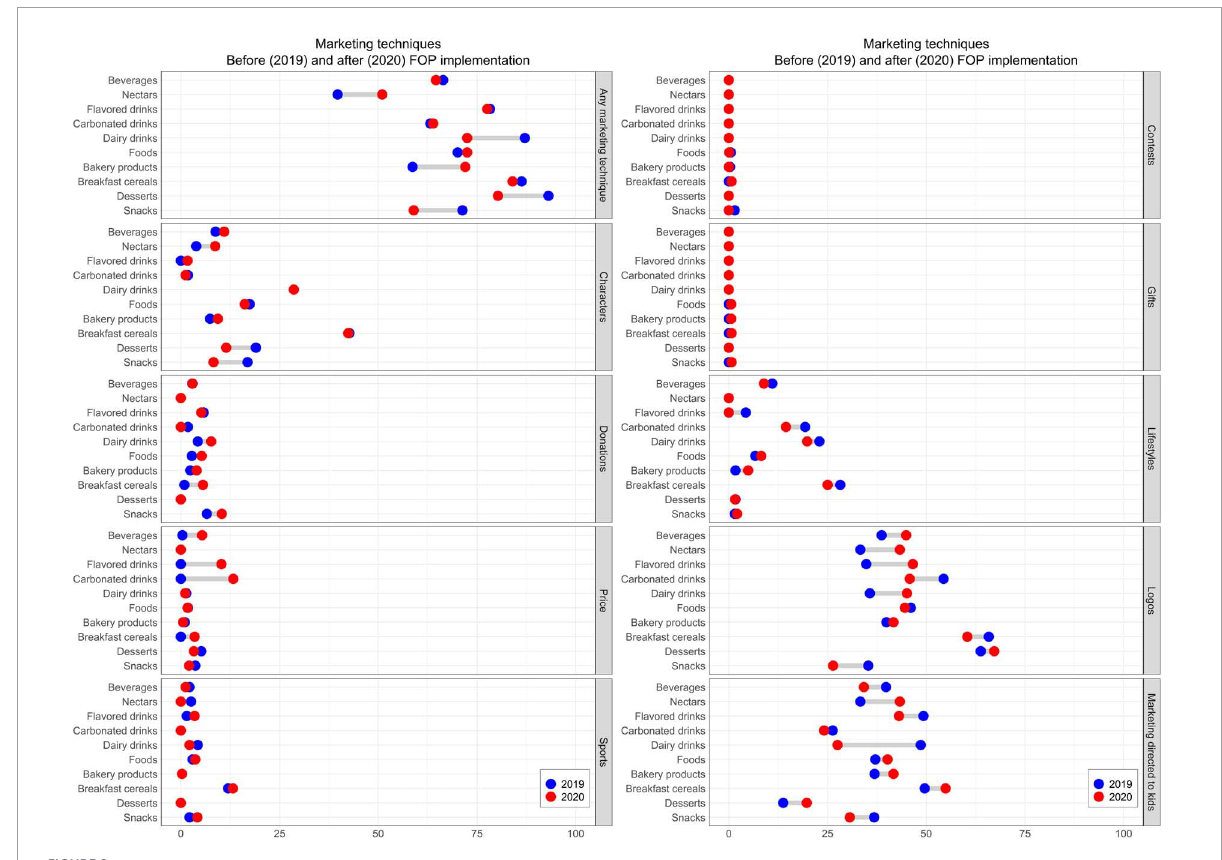
FIGURE2 Marketing techniques used before and after the front-of-package warning label policy implementation, cross sectional analysis.